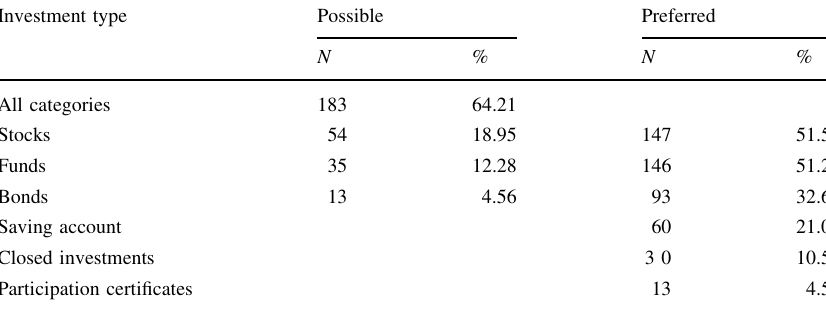
Table 6 Possible and preferred form of SR